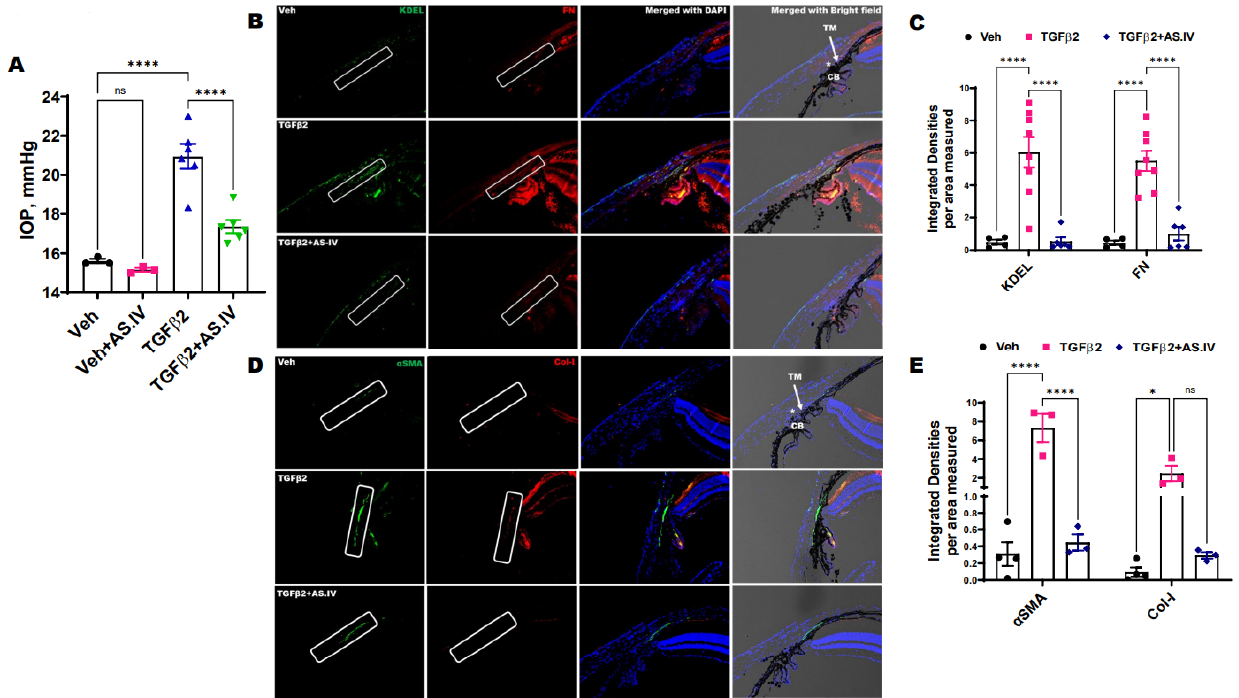
Figure 6. Topical ocular AS.IV treatment attenuates the TGF β 2 induced ocular hypertension in mice. The C57BL/6J mice (3–4 months age) eyes were injected with adenoviral vectors expressing bioactive form of TGF β 2 or Null intravitreally. After 3 weeks following injections, both groups received 5 µL of 1 mM AS.IV topical eye drops in the left eyes and vehicle eye drops (DMSO) in the contralateral right eyes twice daily. ( A ) One week of AS.IV treatment significantly lowered IOPs in TGF β 2-injected left eyes compared to the contralateral right eyes ( n = 3–6 biologically independent samples, data represented as mean ± SEM, Two-way ANOVA, Tukey’s multiple comparisons test, **** p < 0.0001). ( B – E ) Immunostaining ( B , D ) on paraffin sectioned mouse eyes from the groups and their densities ( C , E ) revealed that AS.IV treatment significantly decreased the staining intensities of α SMA, ECM and ER stress markers in TM tissues of Ad5.TGF β 2 injected eyes. Scale bar 50 µ M, TM-trabecular meshwork indicated with an arrow and rectangle box, CB- ciliary body, Schlemm’s canal indicated with an asterisk ( n = 3–8 biological replicates, data represented as mean ± SEM, Two-way ANOVA, Tukey’s multiple comparisons test, * p < 0.05, **** p < 0.0001, ns—not